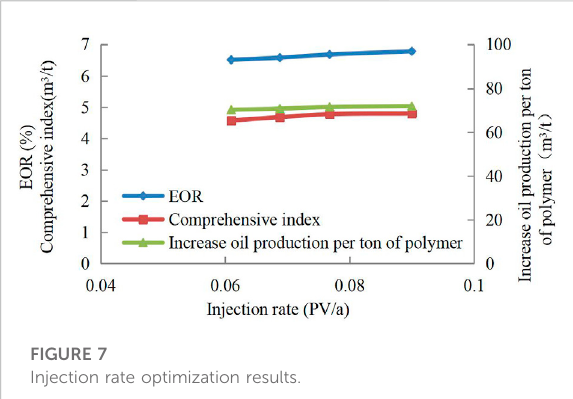
FIGURE 7 Injection rate optimization